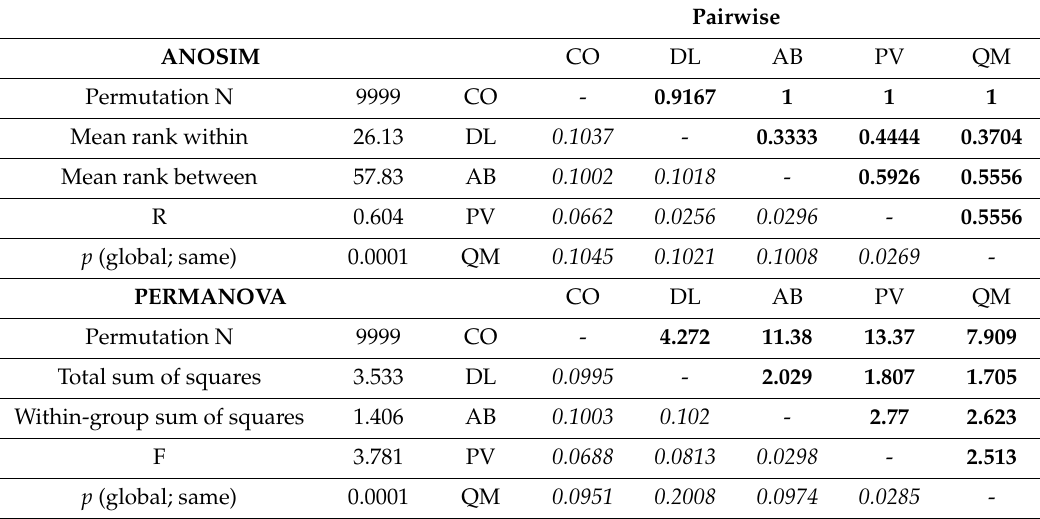
Table 3. Analysis of similarity-dissimilarity in the distribution of S. cerevisiae strains among the di ff erent wineries (ANOSIM and